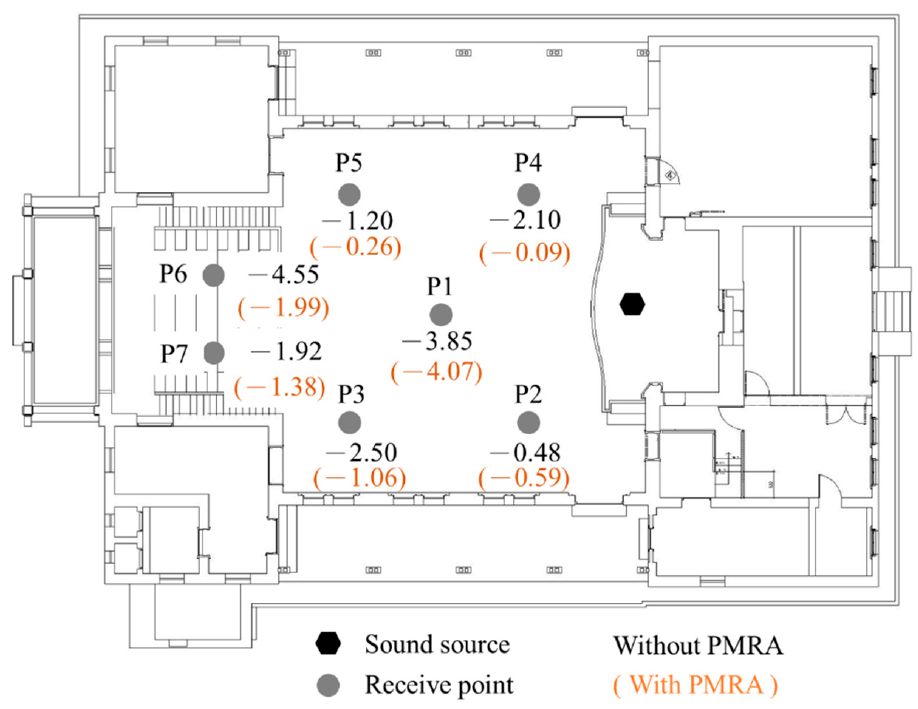
Figure 18. A comparison of C 50 with or without PMRA at 500 Hz.